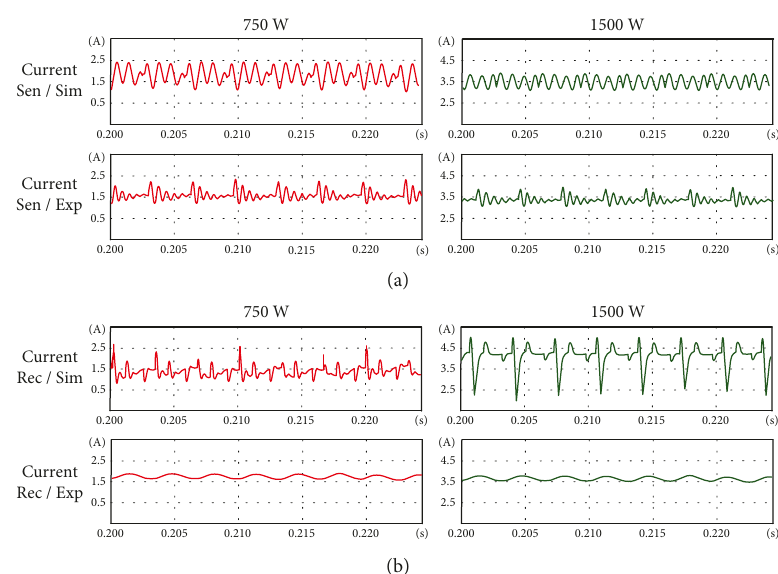
Figure 16: Comparison of the current waveforms based on the electrical load conditions. (a) Comparison of the sending side current waveforms and (b) comparison of the receiving side current